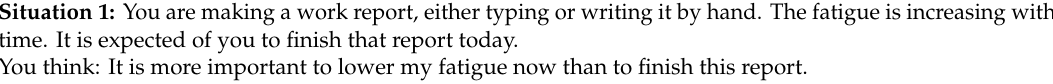
Table 1. Situations in the Goal Pursuit Questionnaire (GPQ) 1 for focus